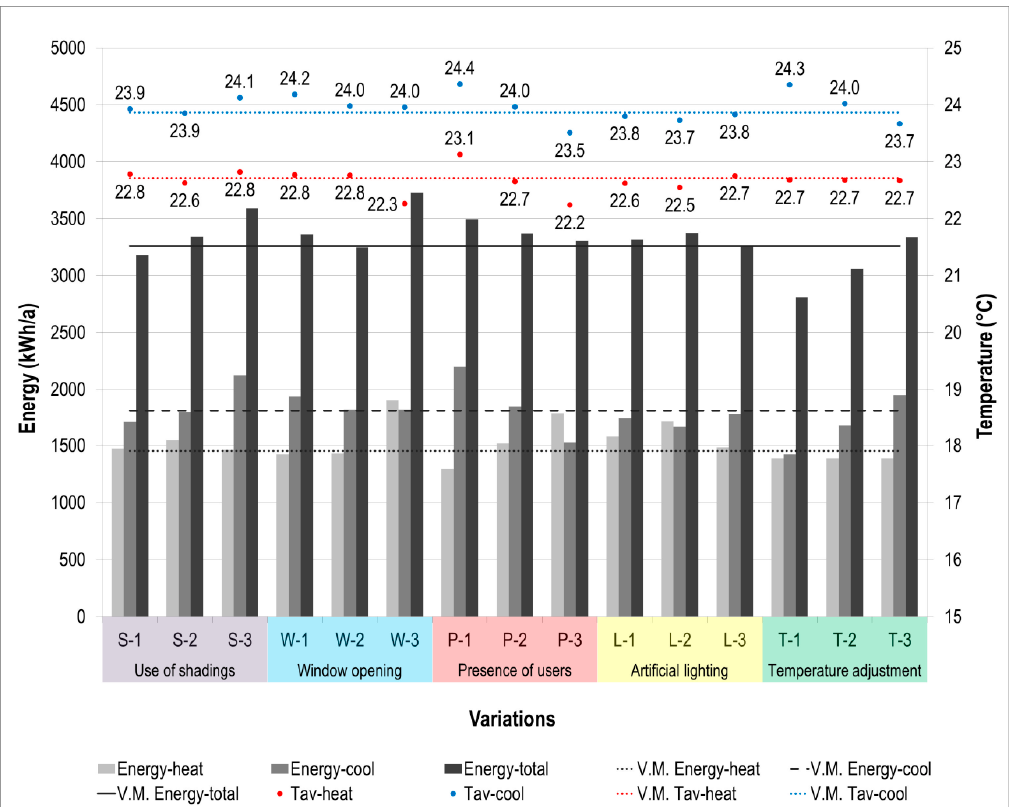
Figure 4. S imulated energy released in offices by ceiling panels and average indoor air temperature for variations of the model according to Table 2 in comparison with the validated model (V.M.).